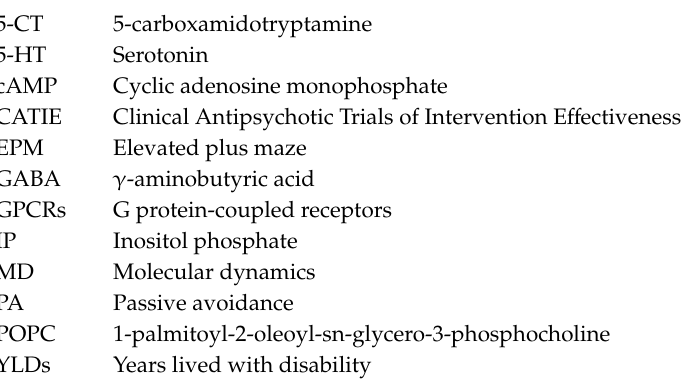
Figure S1. Competition binding curves of D2AAK4 in radioligand binding assays at the indicated receptors. Figure S2. Ligand RMSD values in 200 ns molecular dynamics